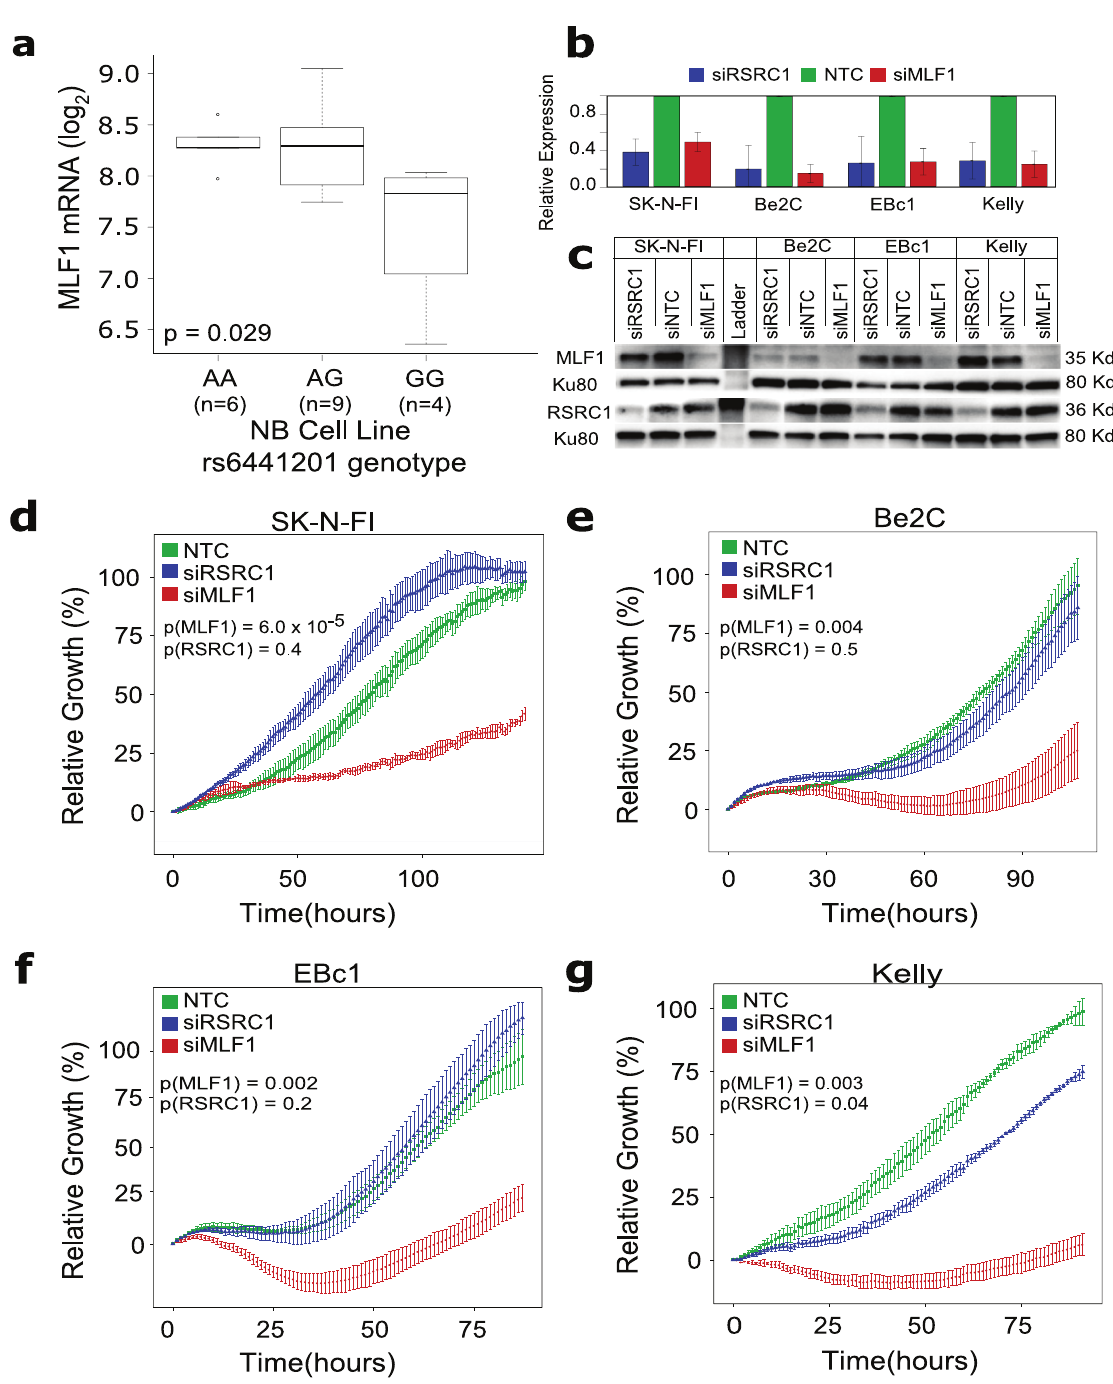
Fig 5. rs6441201 risk allele at 3q25 correlates with increased MLF1 expression and MLF1 silencing results in decreased cell growth in neuroblastoma cells. (a) MLF1 mRNA expression is significantly higherin neuroblastoma cell lines harboring one or more copies of the rs6441201risk allele(A) comparedto neuroblastoma cell lines homozygousfor the protective allele (GG). (b) Silencingof RSRC1 or MLF1 expressionusing pooledsiRNAs resulted in 50–90%reducedmRNA levels by real-time quantitative PCR in neuroblastoma cell lines. (c) Confirmation by Western blot of knockdown at the protein level for RSRC1 and MLF1 after siRNA mediated silencingin neuroblastoma cell lines. (d-g) siRNA mediatedsilencingof MLF1 results in significant growth inhibitionof neuroblastoma cells comparedto non-targeting control siRNA; no effect was observedupon silencingof RSRC1. Cell growth measuredby real-time cell sensingsystem (RT-ces).